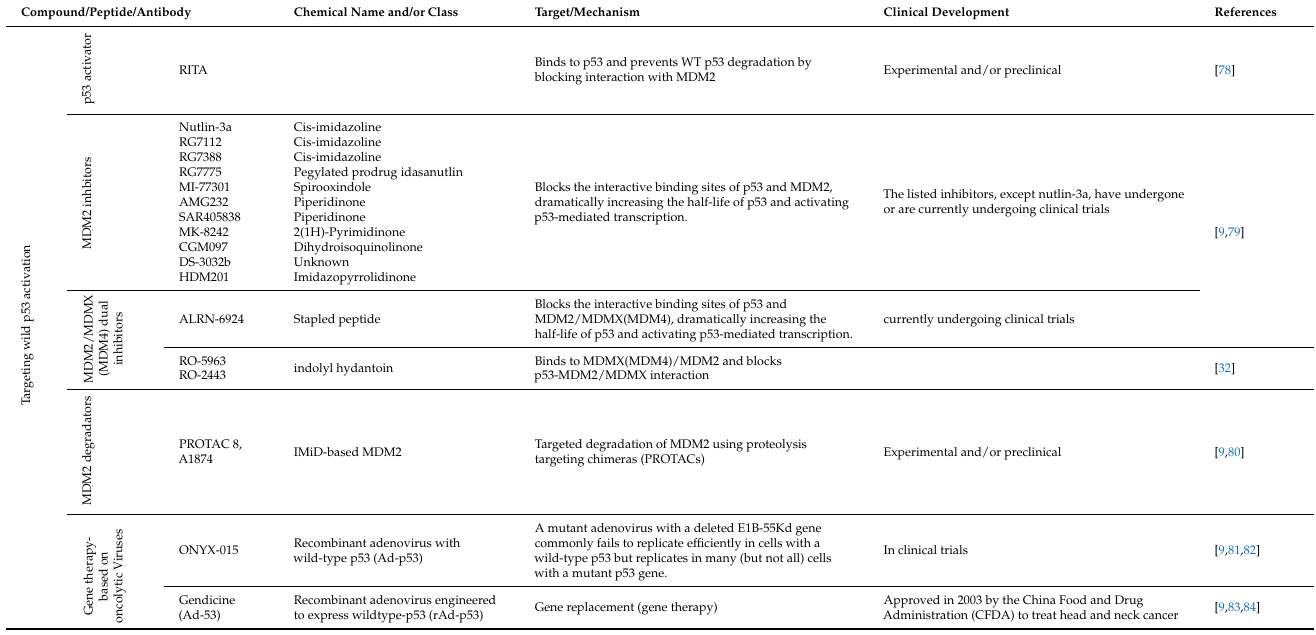
Table 1. Overview of mutant-p53 targeting and wild-type p53 activating